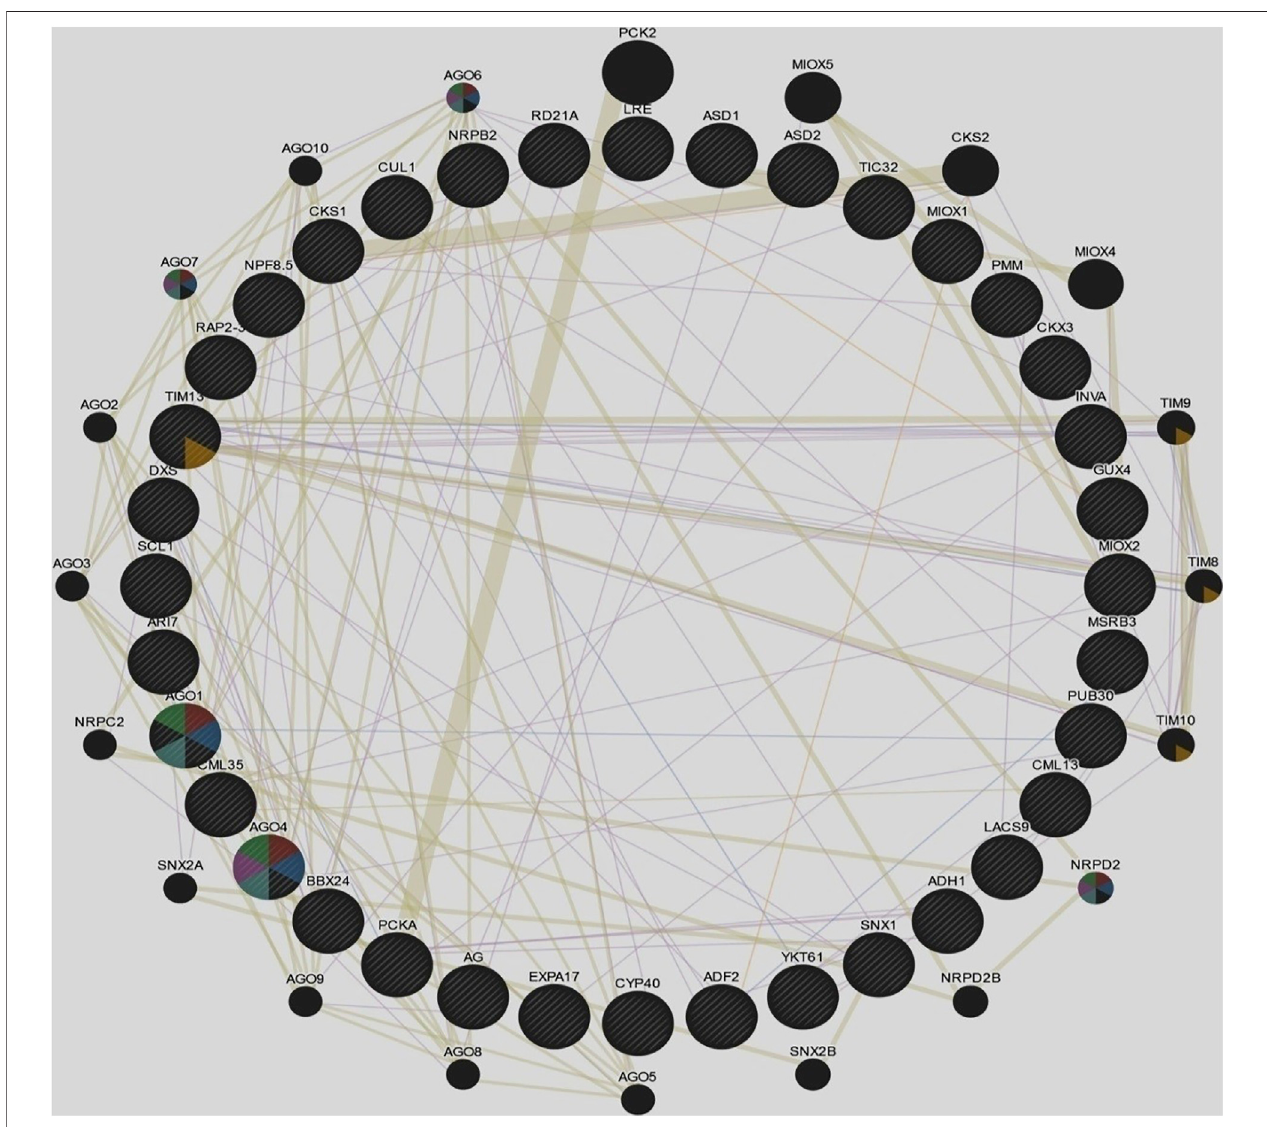
FIGURE 5 | Gene regulatory networks of cluster bean target genes in GENEMANIA against Arabidopsis thaliana .